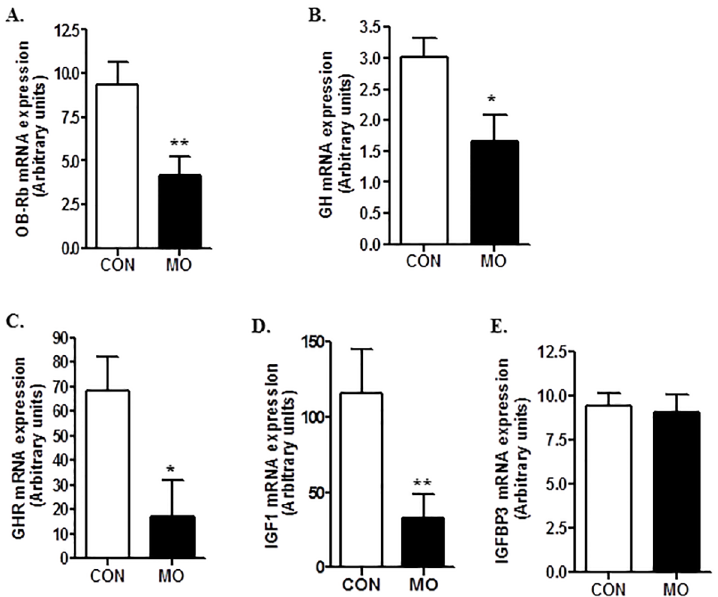
Fig 4. Gene expression of OB-Rb (A), GH (B) in pituitary, and GH receptor(GHR, C), IGF1(D), and IGF binding protein 3 (IGFBP3, E) in liver samples of CON (open bars, n = 6) and MO (solid bars; n = 6) adult male F1 offspring. * Means ± SEM differ, ( P < 0.05). ** Means ± SEM differ, ( P < 0.01).